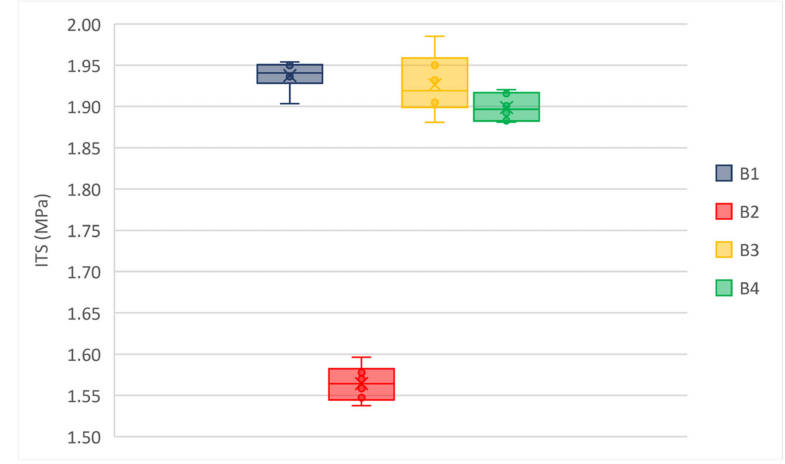
Figure 7. Average ITS of binder mixtures, T = 25 ◦ C.